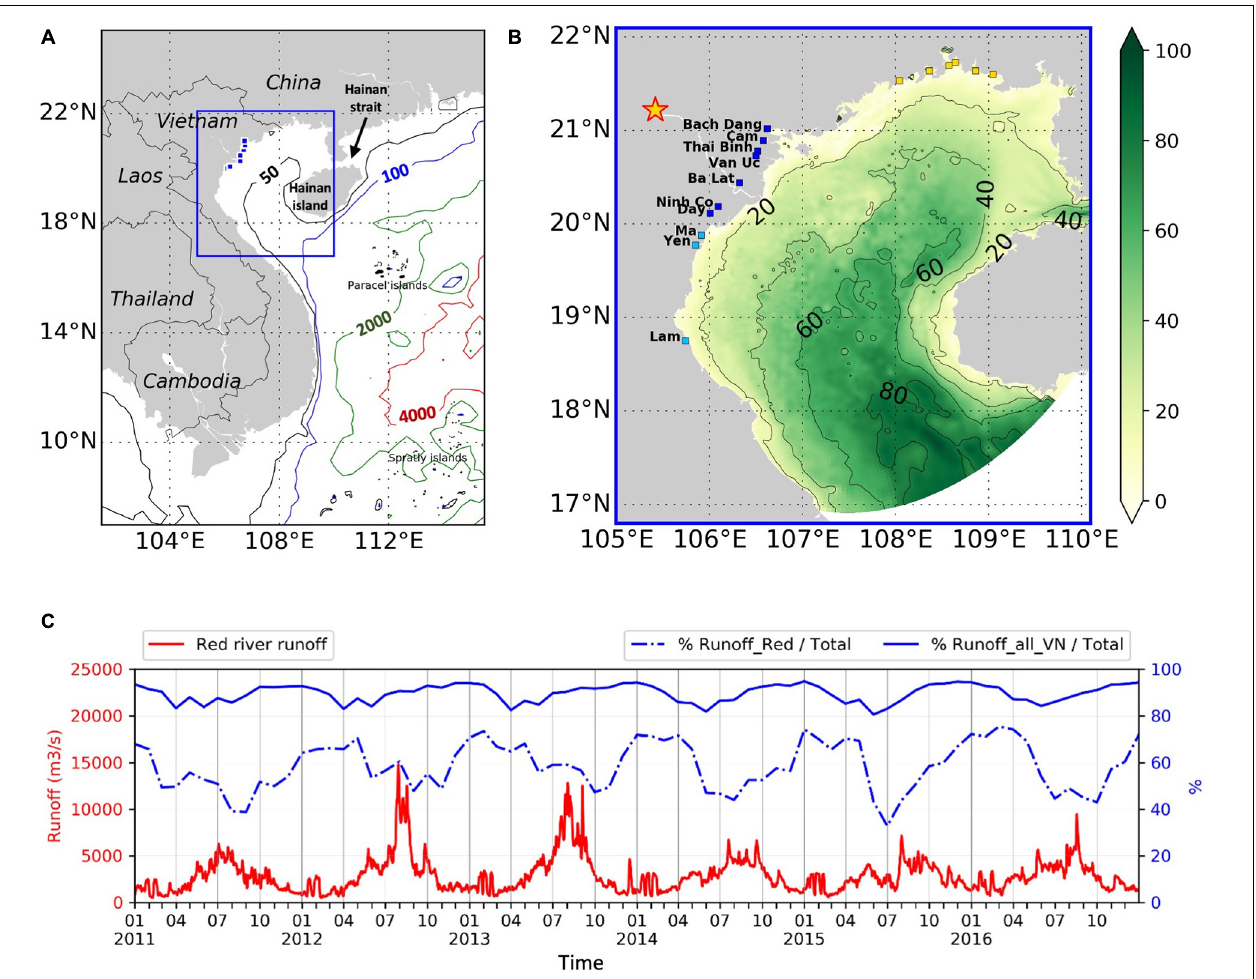
FIGURE 1 | (A) Location of the Gulf of Tonkin. Blue dots show the location of the river mouths of the Red River system. Contour lines indicate the bathymetry of the area. (B) Model domain with bathymetry. The star indicates the location of Son Tay hydrological station at the apex of the delta. Blue boxes show the most upstream points where the runoffs flow to the model. Cyan and yellow boxes show the location of other river mouths in the south and north of RR, respectively. (C) Daily Red River discharge in the model configuration, from National Hydro-Meteorological Service data (red curve, left y-axis). Blue dashed line: Percentage of Red River runoff compared to total runoff (sum of runoff from Red River, other rivers in Vietnam, rivers in China). Blue line: percentage of all rivers in Vietnam (including Red and other rivers in the GOT) compared to total runoff. Blue lines are referred to the right